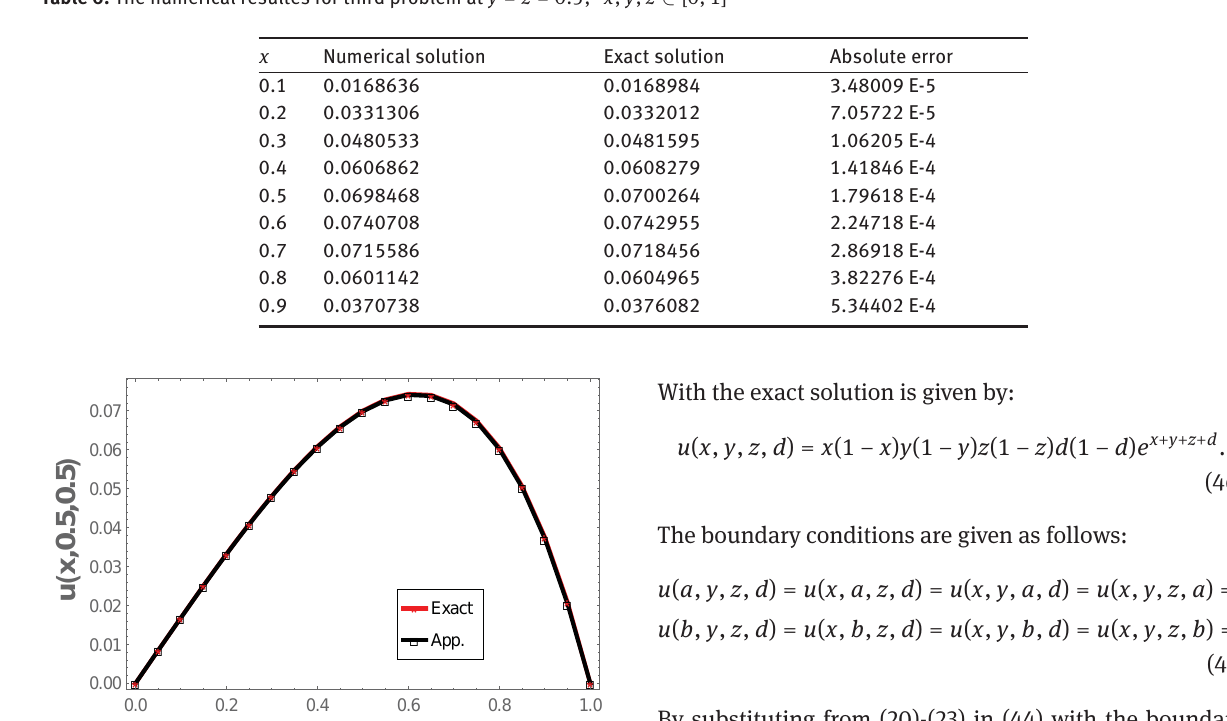
Table 6: The numerical resultes for third problem at y = z = 0.5, x , y , z ∈ [0, 1]